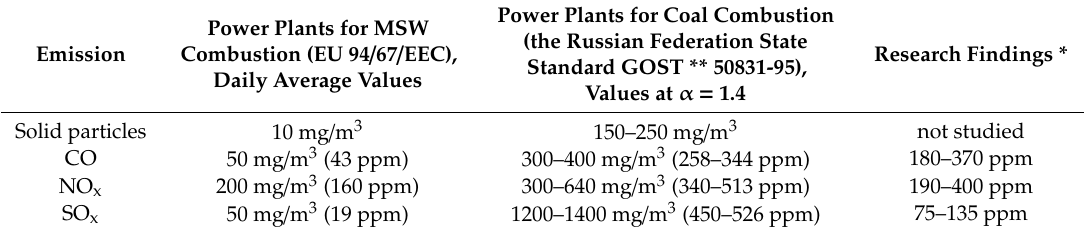
Table 6. Emission limits for power plants [10] and research